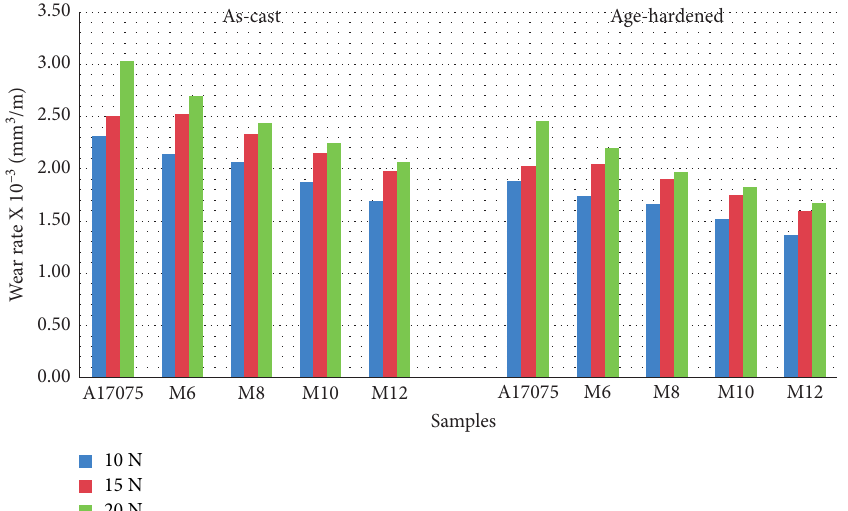
Figure 7: The wear rate of as-cast and age-hardened specimens at